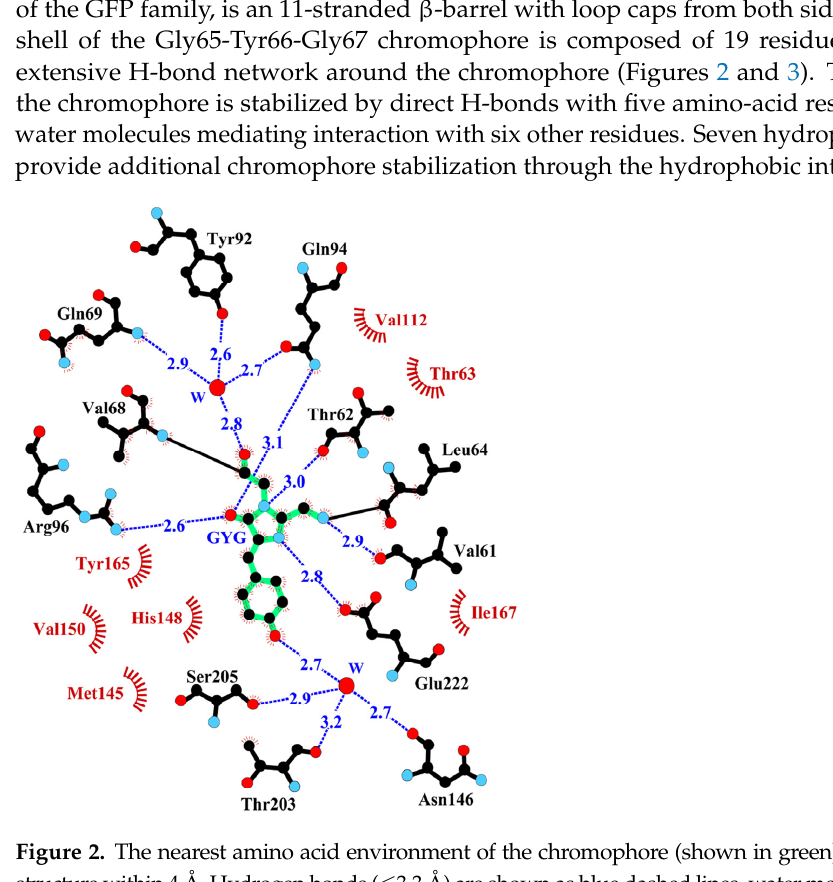
Figure 3. View of the GYG chromophore (shown in green) with key adjacent residues in the 2Fo-Fc electron density (cuto ff ρ = 2.0 σ ) Hydrogen bonds ( ≤ 3.3 Å) are shown as black dashed lines and water molecules (W) as red spheres ( fi gure created with PYMOL [12]). 2.3. Electric and Dynamic Properties of the Chromophore-Binding Site